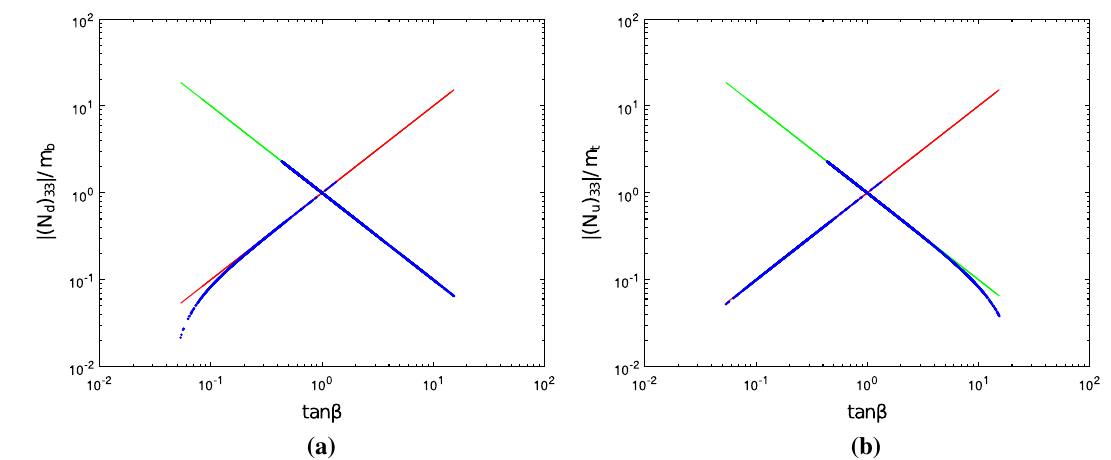
(cid:8) (cid:8) Fig. 2 a | ( N d ) 33 | m b and b | ( N u ) 33 | m t versus tan β for the parameter space points (in blue) which survive all the theoretical and experimental constraints. The green lines correspond to y = cot β and the red lines correspond to y = tan β , where y is | ( N d ) 33 | in ( b )